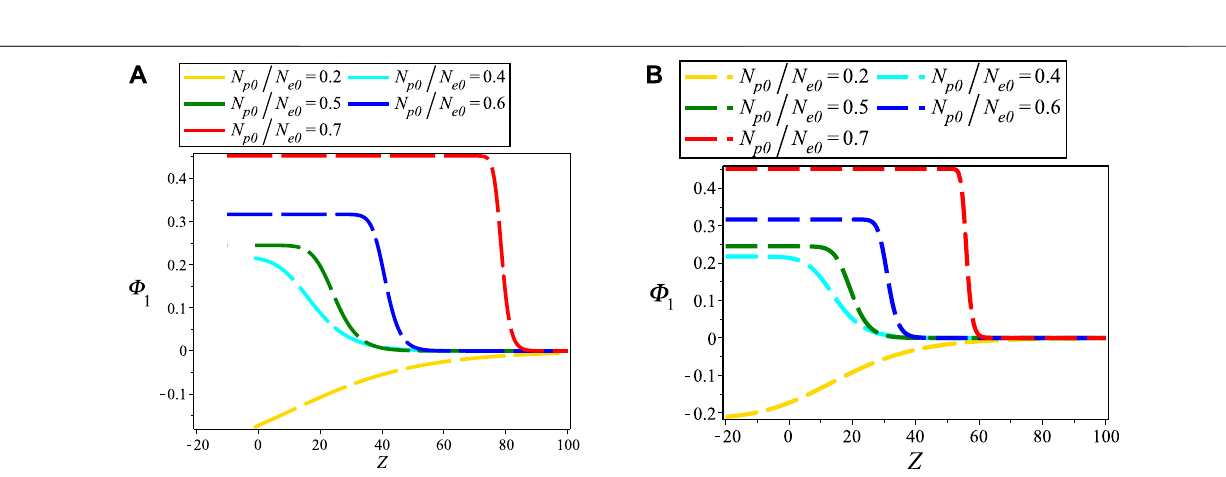
Frontiers in Physics |